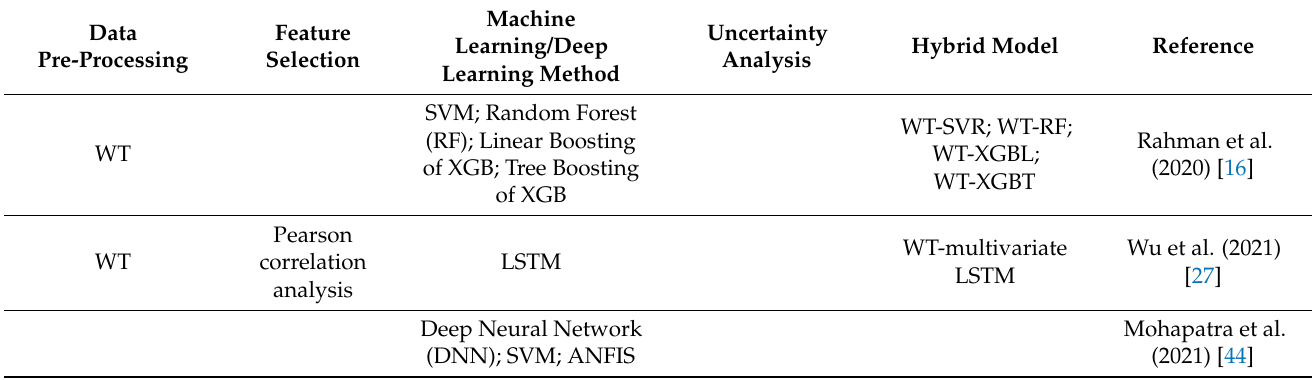
Table 1. Summary of machine learning methods in groundwater level modeling for arid and semi-arid regions in the latest